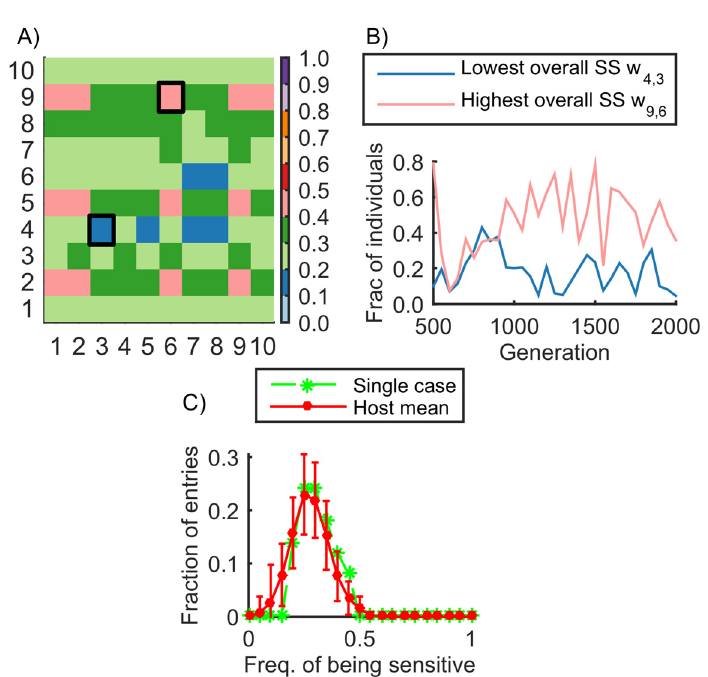
Fig 4. Distribution of sensitivity throughout the network. A) Frequency of being a sensitive interaction in the N × N matrix of interactions (with N = 10) in a typical simulation. From generation 500 onwards we identified the sensitive gene interactions w ij ( SS ij > 0), then measured the frequency for each w ij being sensitive within the population, at intervals of 50 generations. We sum the frequencies over time and normalize to the interval [0,1] as indicated by the colors. Generally there are no interactions that appear to dominate within each population over many generations. B) Detailed progression of sensitivity over time for two particular interactions in (A). These interactions had the lowest (blue) and highest (pink) overall sensitivity, as indicated by the black squares in (A). C) Distribution of the frequency of being sensitive in all N × N interactions for all host individuals (green dashed line: the host population of (A), red solid line: mean of 100 simulations). Since distributions are mostly right-skewed there are no interactions that dominate in terms of sensitivity. Error bars indicate one SD.